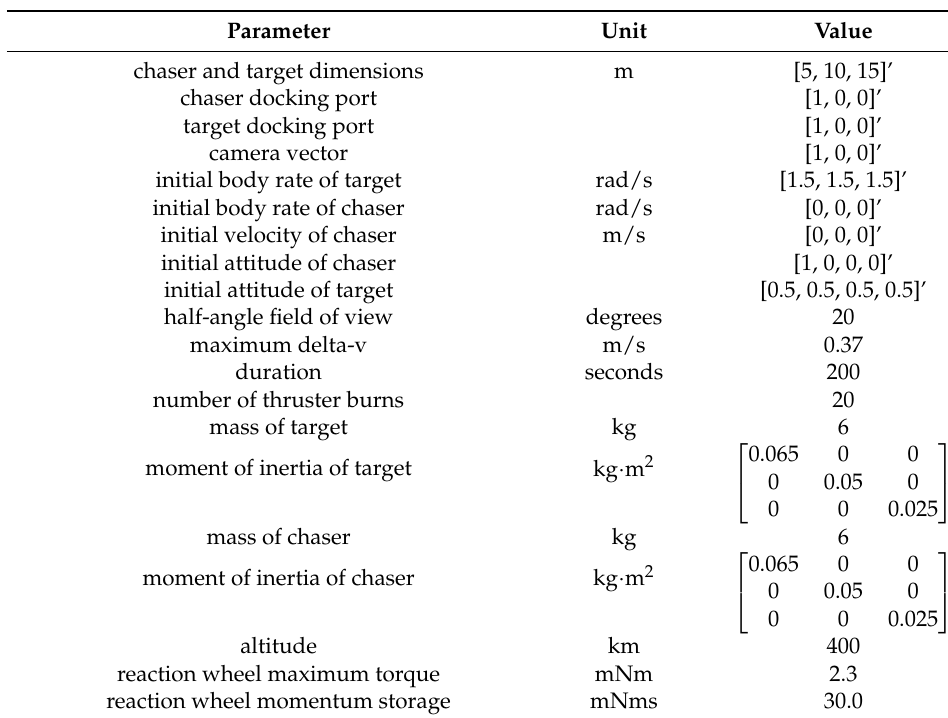
Figure 10. 3D view of trajectories started at 14 different positions in space. Table 1. Chaser and target